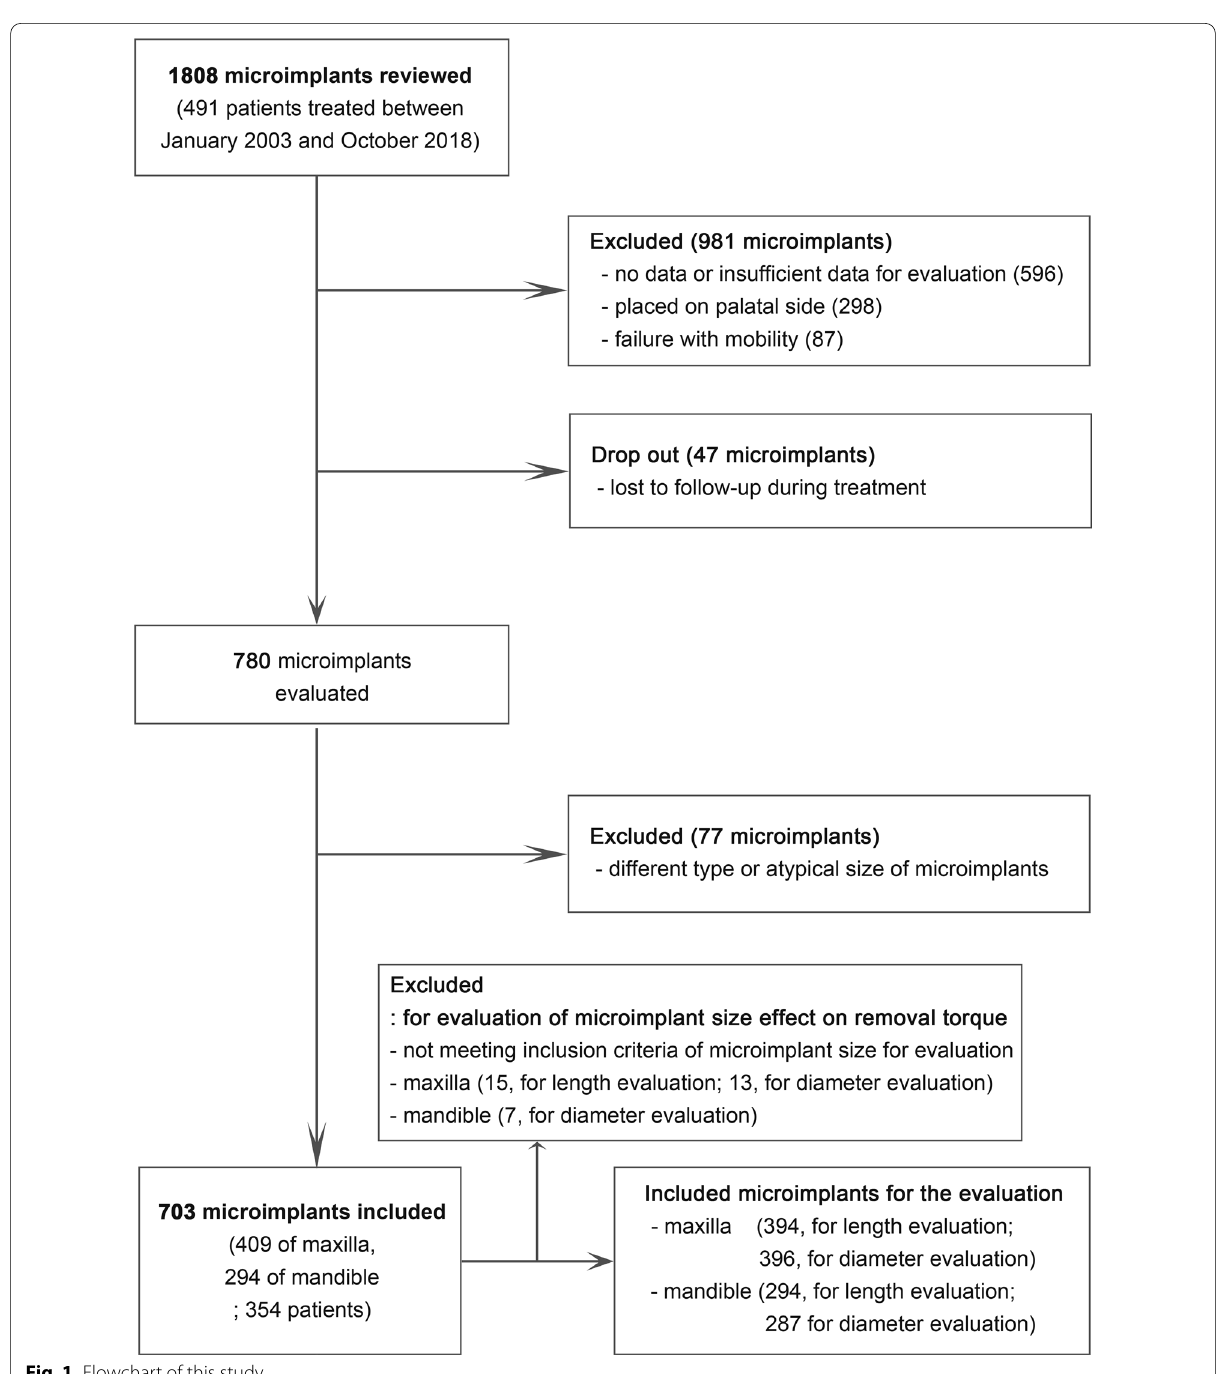
Fig. 1 Flowchart of this